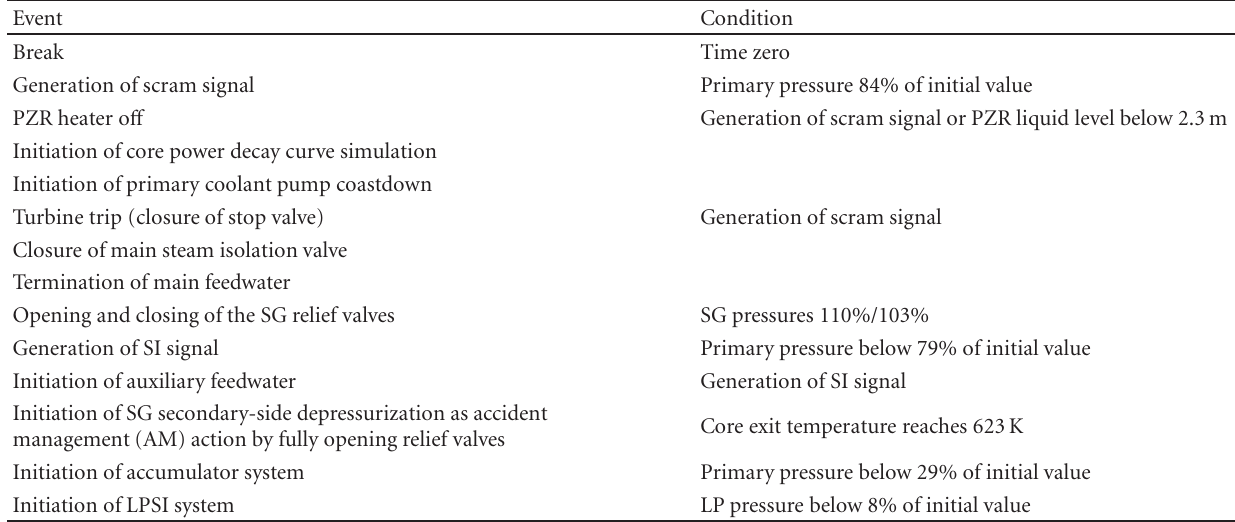
Table 2: Control logic of Test 6-1